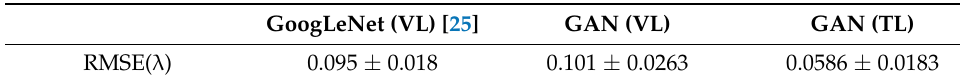
Table 2. The performance of two models—simulated image.